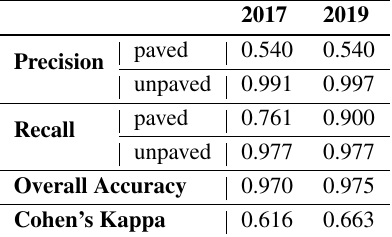
Table 3. Accuracy assessment values for street classifications for 2017 and